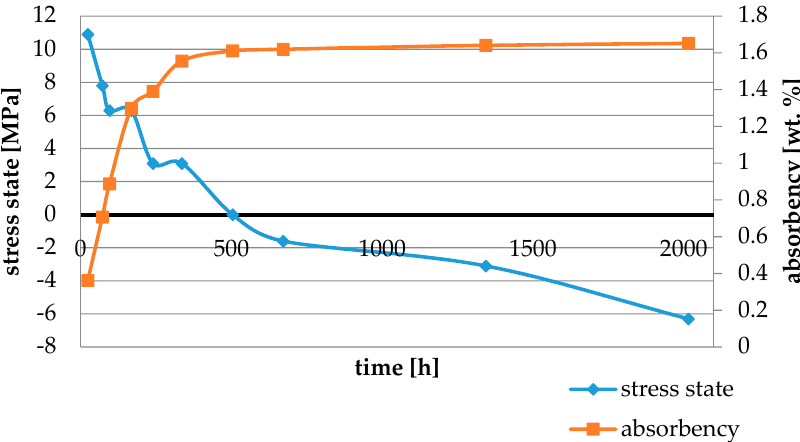
Figure 9. The influence of water sorption (2016 h water ageing) on the absorbency and contraction stress generated during the photopolymerization of Calibra Universal.